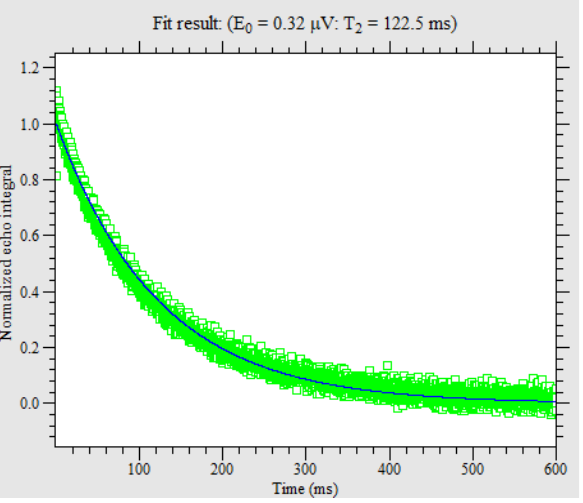
Figure 7. NMR signal of a sample. The years of aging of the samples from each factory and the transverse relaxation time T 2 are shown in Figure 8.